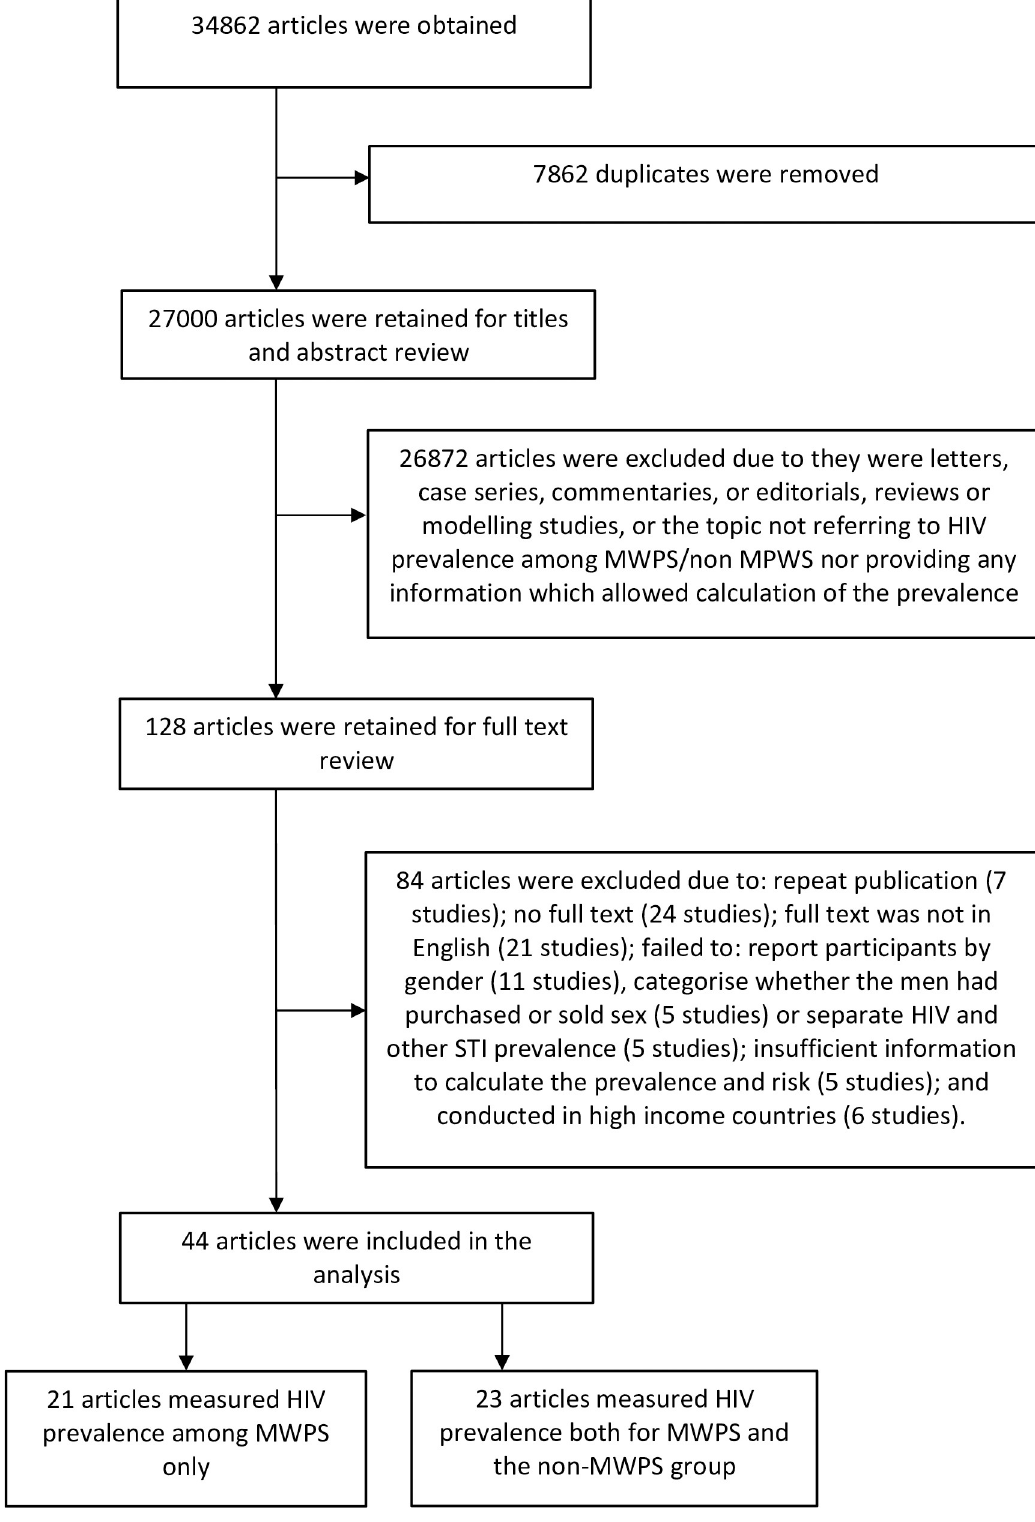
Fig 1. A flow diagram of the search and paper selection